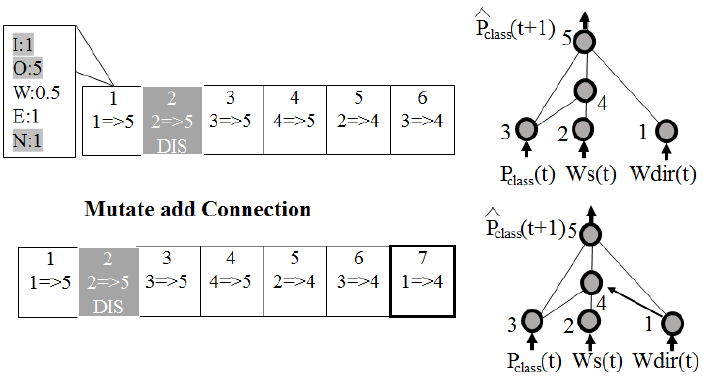
Figure 7. Mutation by appending a connection, where the link from Node 1 to Node 4 is inserted.